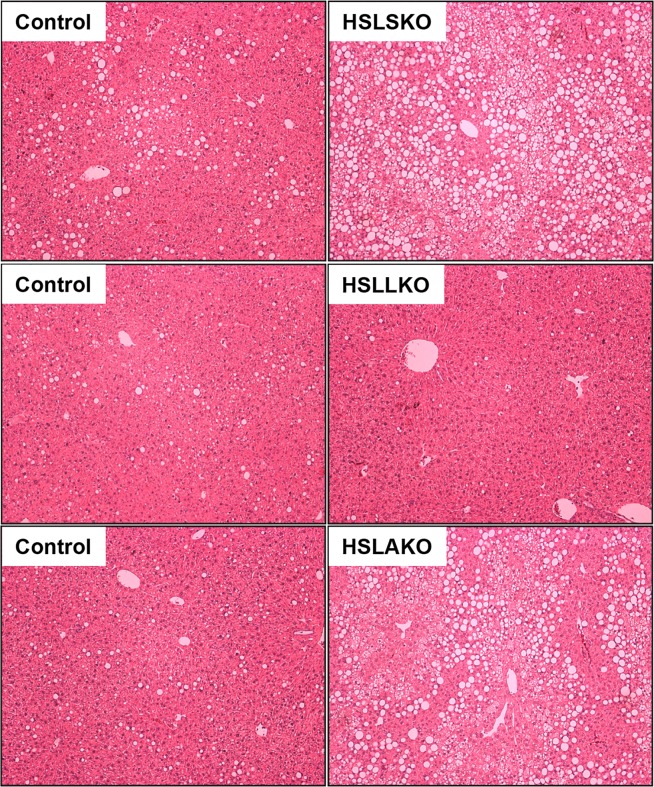
Histological confirmation of hepatic steatosis in HSLSKO and HSLAKO livers, but not in HSLLKO liver.8-month-old mice were fasted for 5 hours. Representative H&E sections of liver are shown from mice of each genotype.